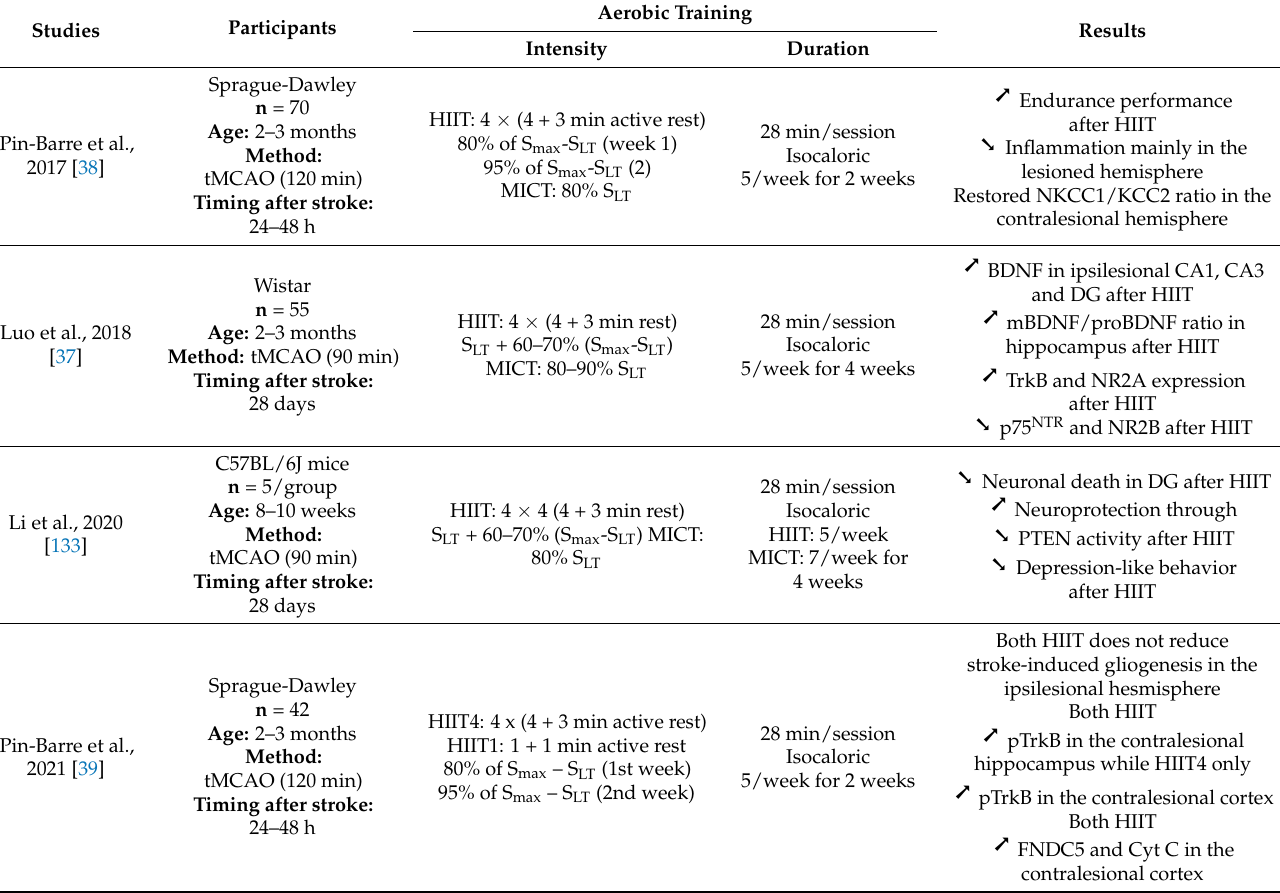
Table 2. Summary of aerobic training protocols and their effects on cognition in poststroke rats.